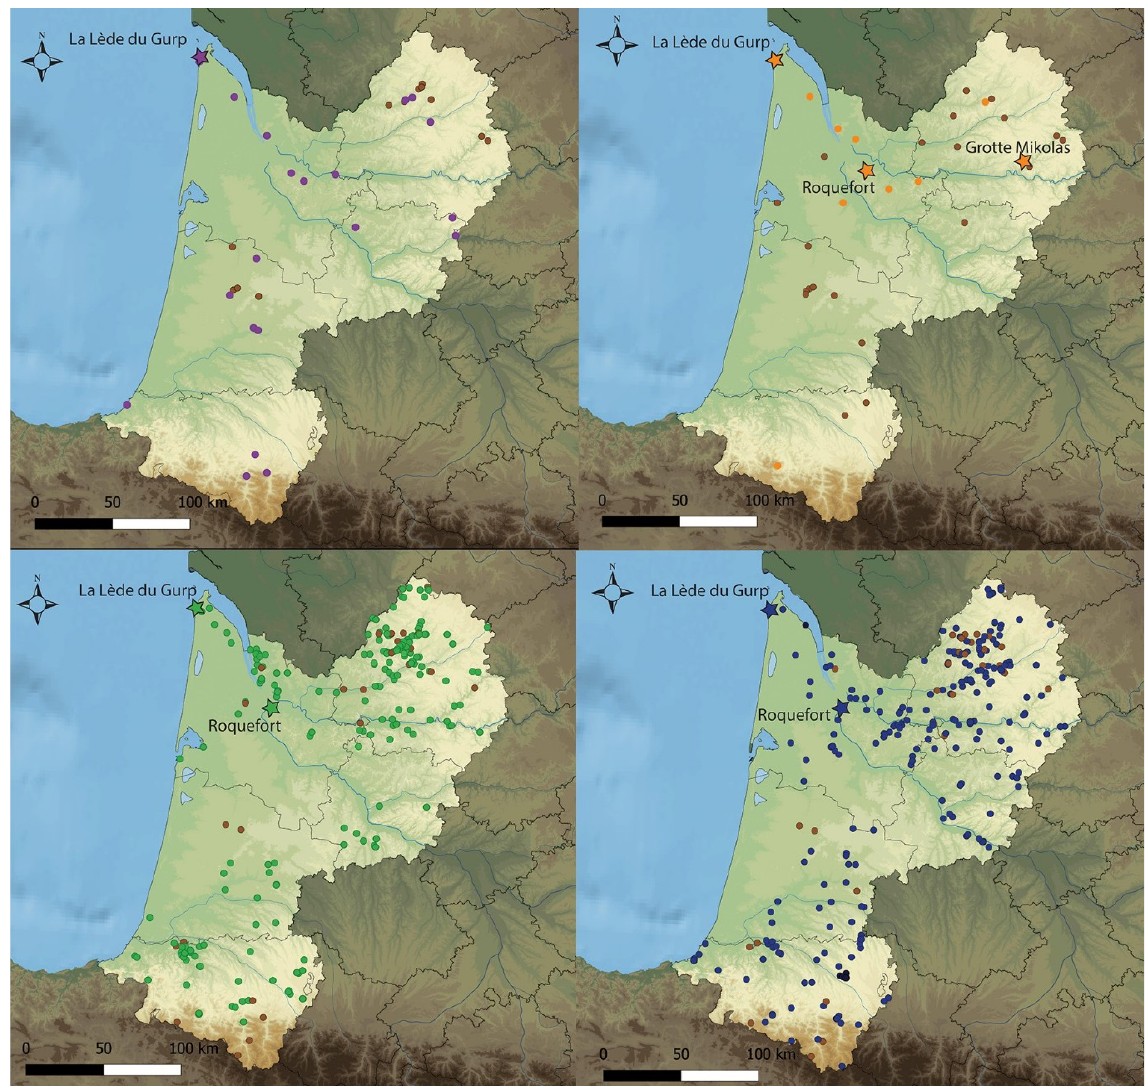
Figure 1. Early Neolithic to Late Neolithic occurrences in the Aquitaine region. Starred sites are discussed in the text of the article. (purple dots: Early Neolithic; orange dots Middle Neolithic; green dots Late Neolithic, blue dots Final Neolithic, brown dots sites with multiple phases. Map made after regional archaeological